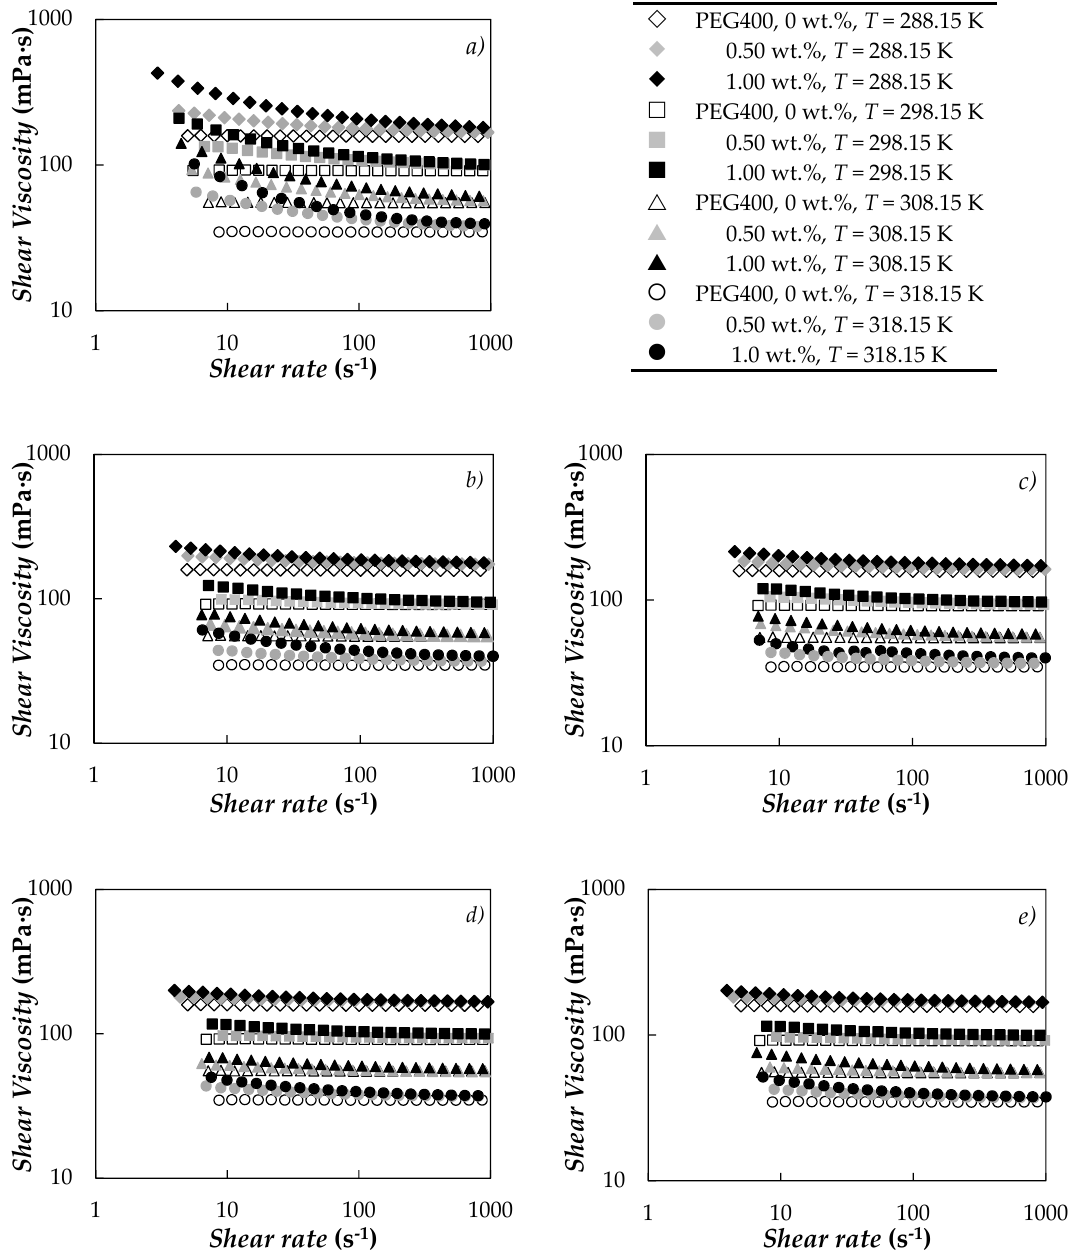
Figure 5. Flow viscosity curves of PEG400-based nanofluids containing: ( a ) CB, ( b ) nD87, ( c ) nD97, ( d ) G/D-p or ( e ) G/D-r carbon nanostructures.